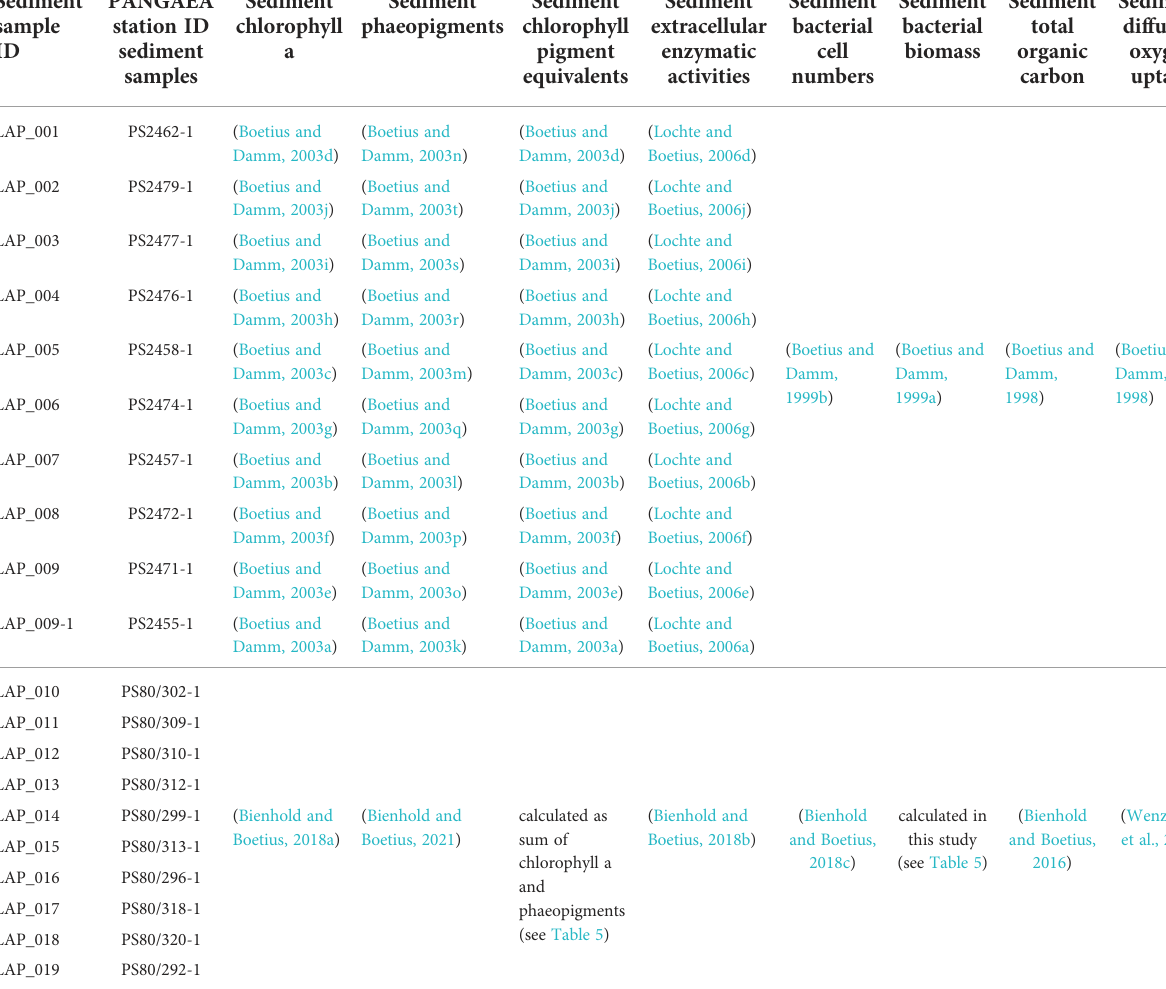
TABLE 2 Dataset citations for sediment data from the Laptev Sea continental slope in 1993 and 2012. Sediment